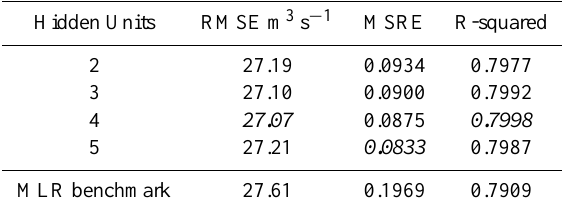
Table 3. Calibration performance of candidate models for Scenario A. Best performing ANN models for each metric are in italic.